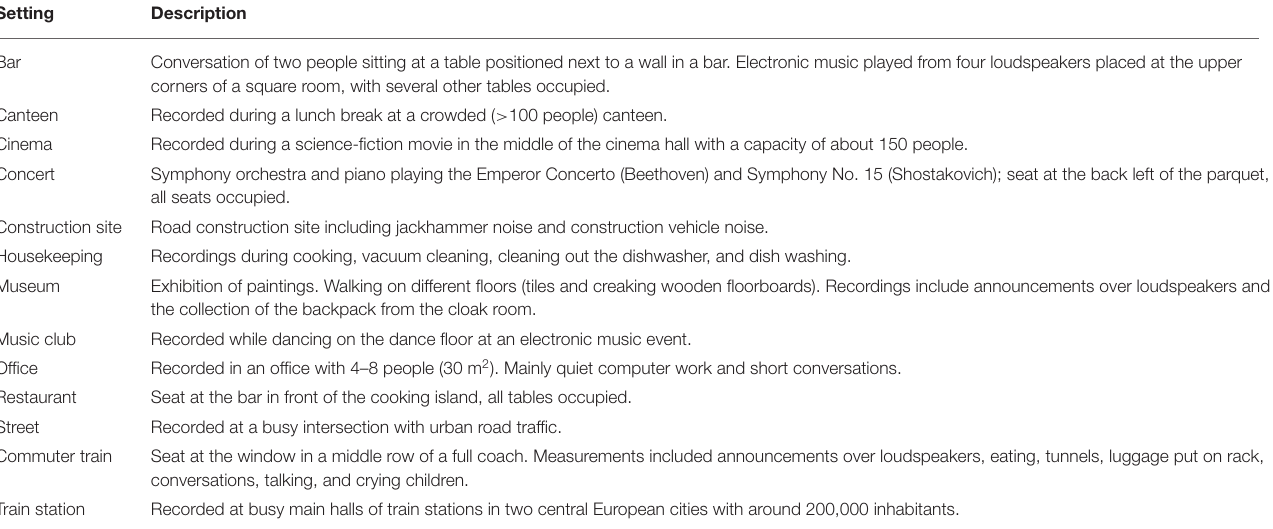
TABLE 1 | Overview of settings for environmental noise